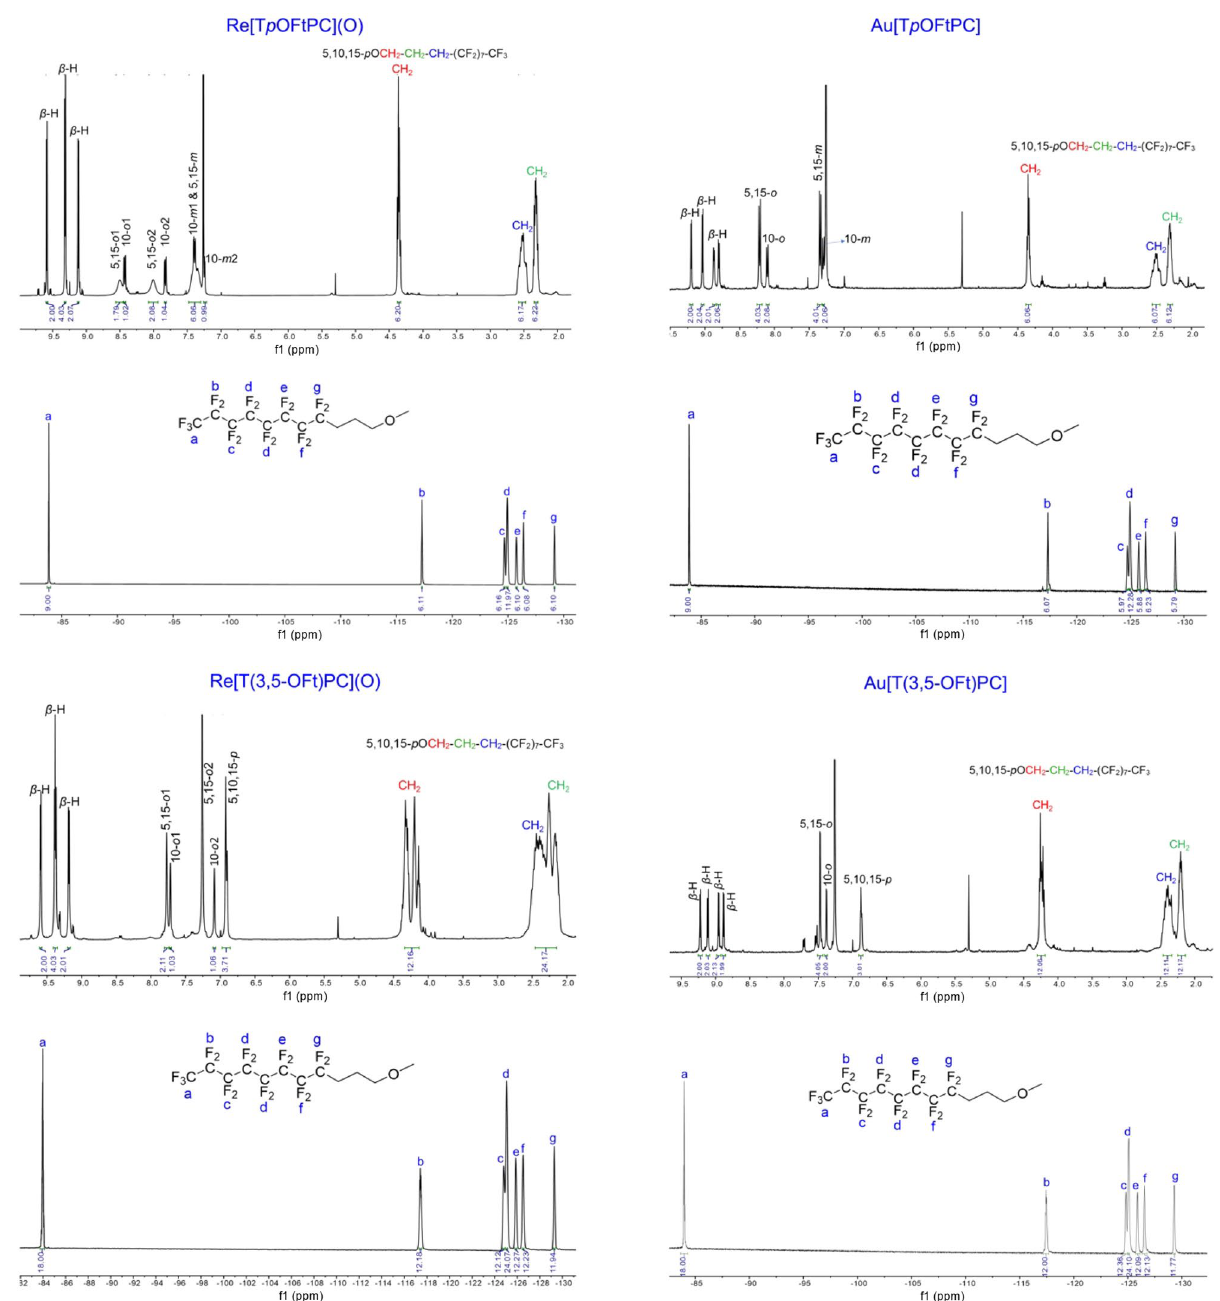
Figure 5. 1 H and 19 F NMR spectra of M[T p OFtPC] and M[T(3,5-OFt)PC] (M = ReO,